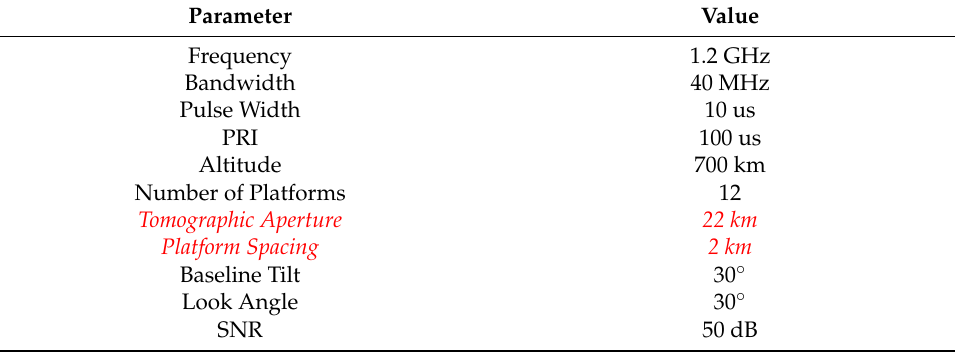
Table 11. Parameters used for Example